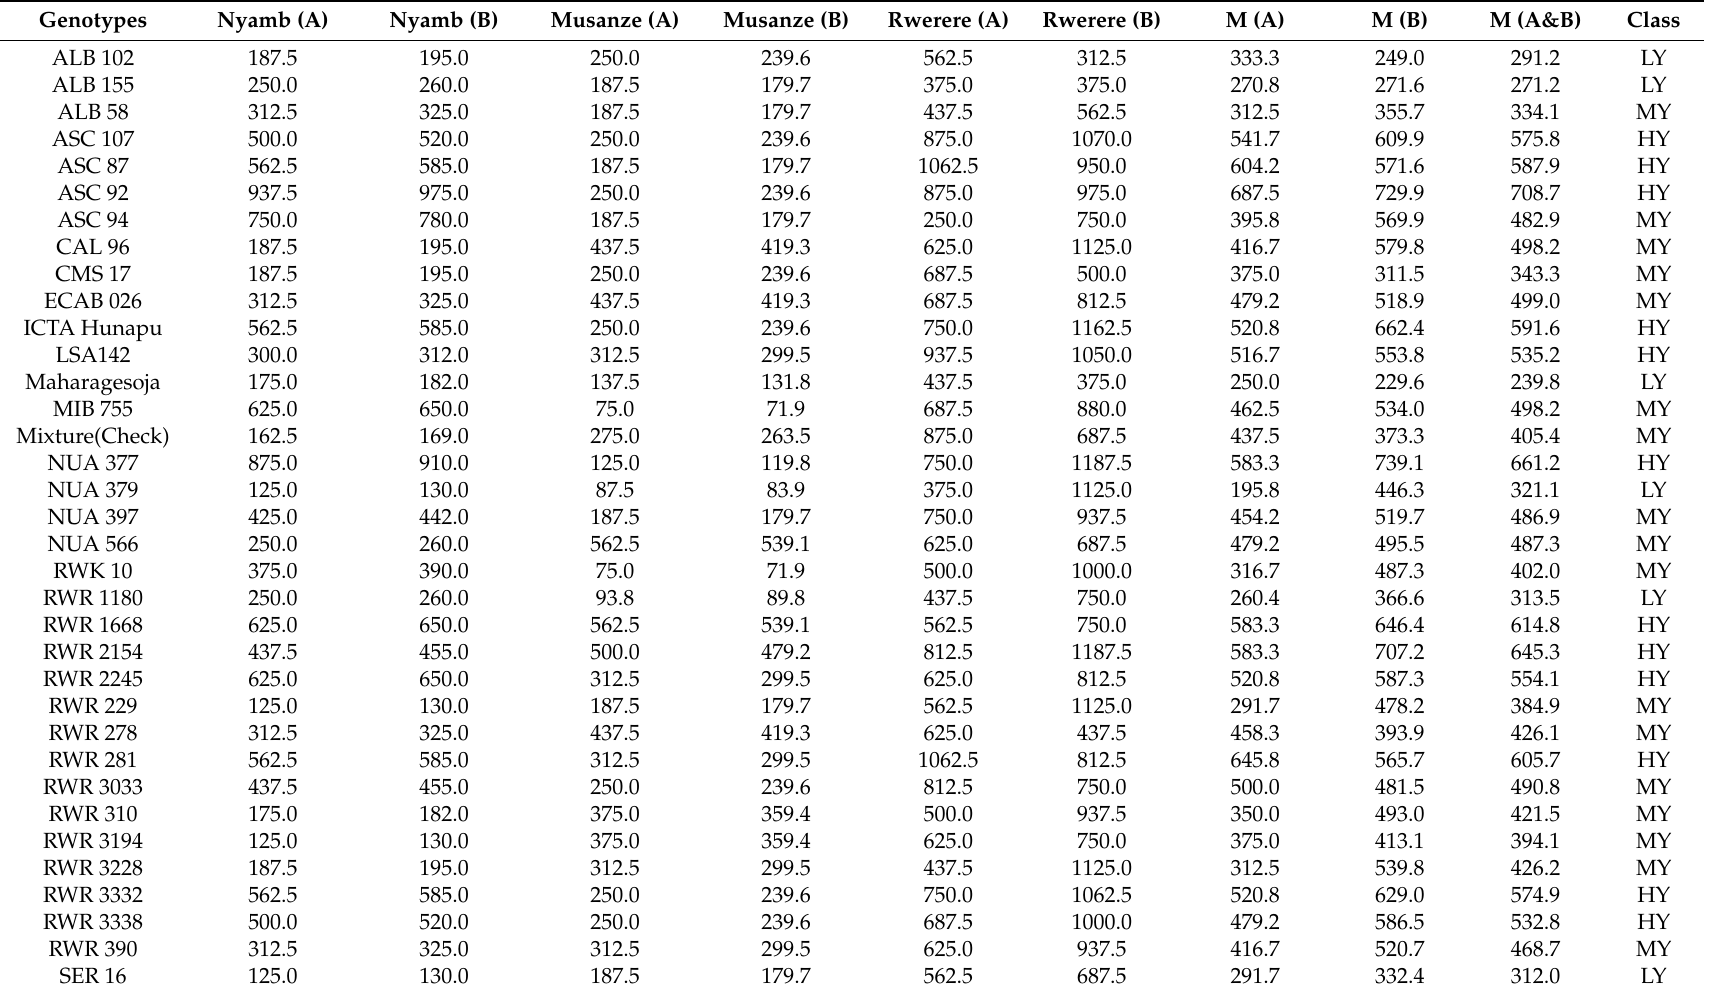
Table 7. Average yield (kg ha − 1 ) of bush bean genotypes evaluated in six